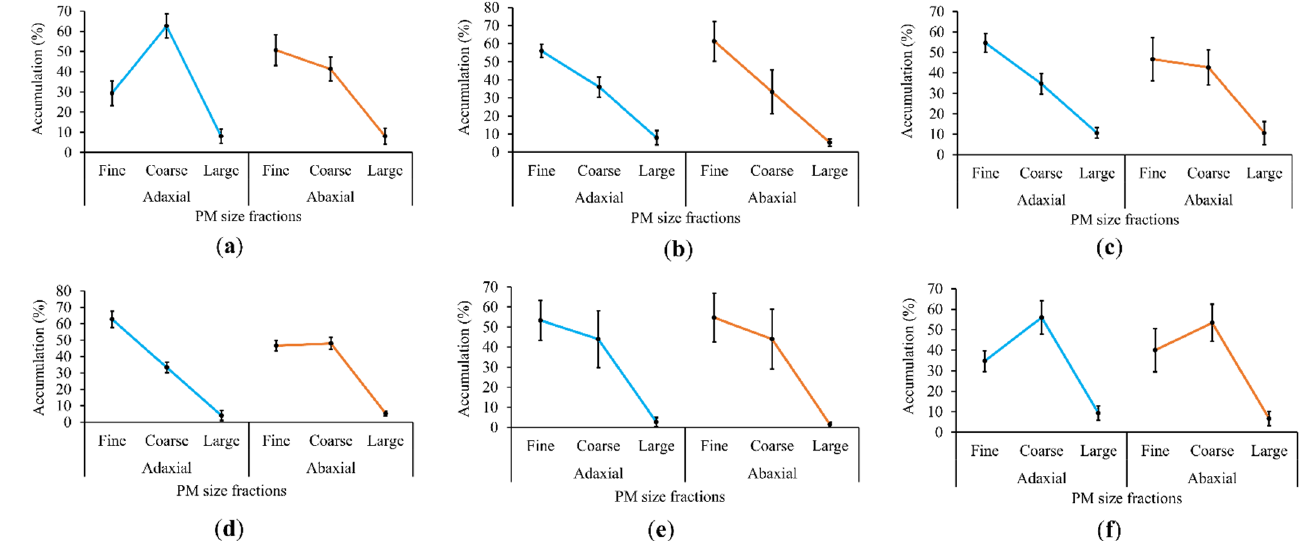
Figure 3. Accumulation of assessed PM sizes (mean ± SD) by adaxial and abaxial leaf surfaces of plant species: ( a ) M. oleifera ; ( b ) O. paniculosa ; ( c ) P. guajava ; ( d ) C. roseus ; ( e ) G. fruticosus ; ( f ) I. batatas . Trees first then forbs.